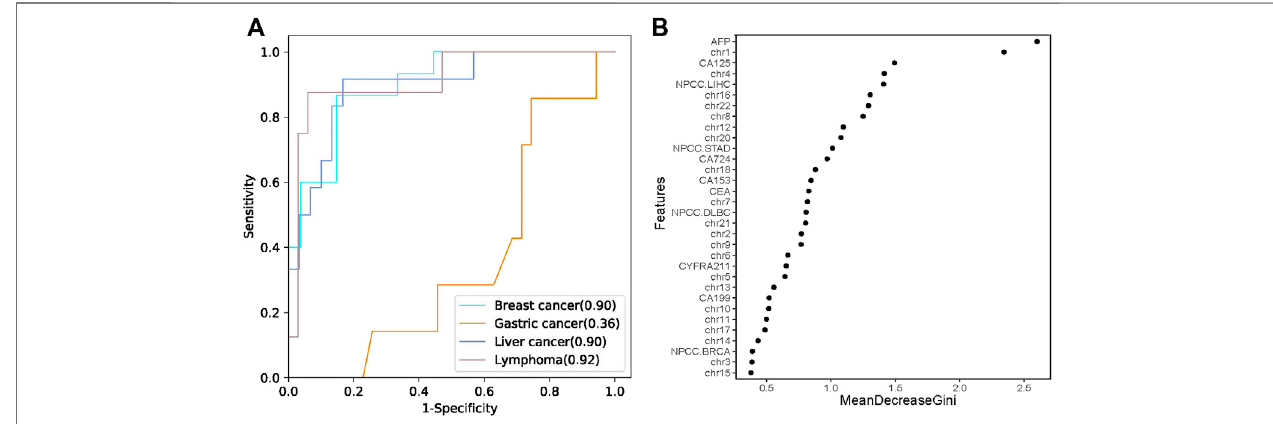
FIGURE4| Thetumortissueoriginclassi fi er. (A) Theperformancesoftherandomforestclassi fi erestimatedbyleave-one-outcrossvalidation. (B) Theimportance of different features in the random forest classi fi er. MeanDecreaseGini is the variable ’ s total decrease in node impurity measured by the Gini impurity criterion.